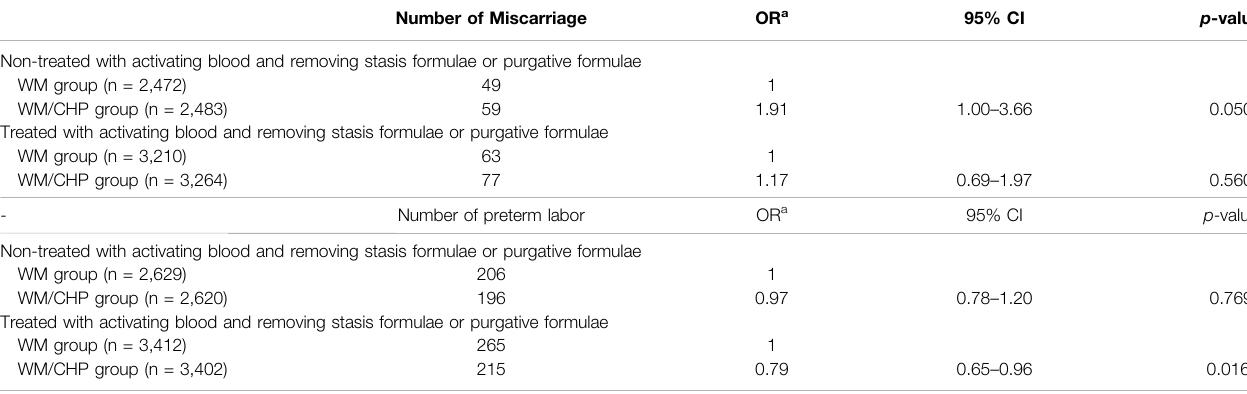
TABLE3| Subgroupanalysisforoddratiosofbirthoutcome(pretermlaborormiscarriage)basedontreatedwithactivatingbloodandremovingstasisformulae orpurgative formulae between WM and WM/CHP